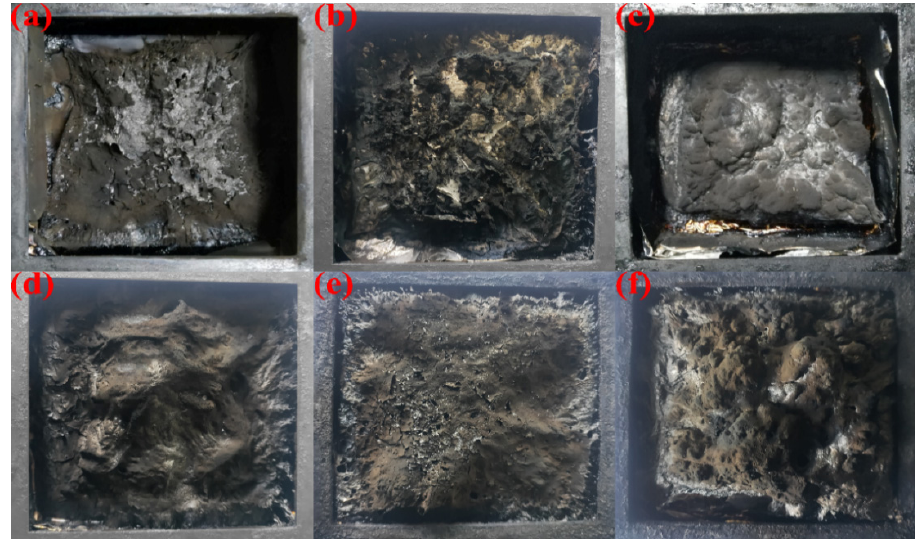
Figure 12. The digital photos of char residues after cone calorimeter test of neat RPUF ( a ), RPUF- MOF/MWCNTs 2 ( b ), RPUF-T ( c ), RPUF-T/MOF/MWCNTs 2 ( d ), RPUF-C-MOF/MWCNTs 2 ( e ), and RPUF-T/C-MOF/MWCNTs 2 ( f ). Table 4. Characteristic CC data of the chosen RPUFs.